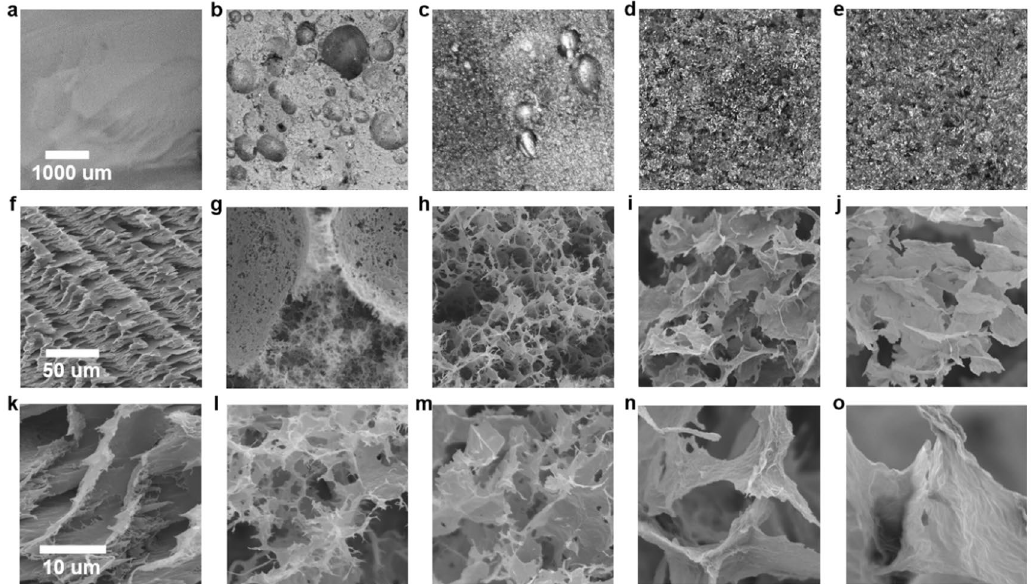
Figure 2. ( a – e ) DM and ( f – o ) SEM images of GO/PVA aerogels. PVA ( a , f , k) , GPA-1 ( b , g , l ), GPA-2 ( c , h , m ), GPA-3 ( d , i , n ), GO ( e , j , o ). Magnifications: ( a – e ) × 20, ( f – j ) × 500, and ( k – o ) × 3000. Same scale bars apply to images with equal magnification.